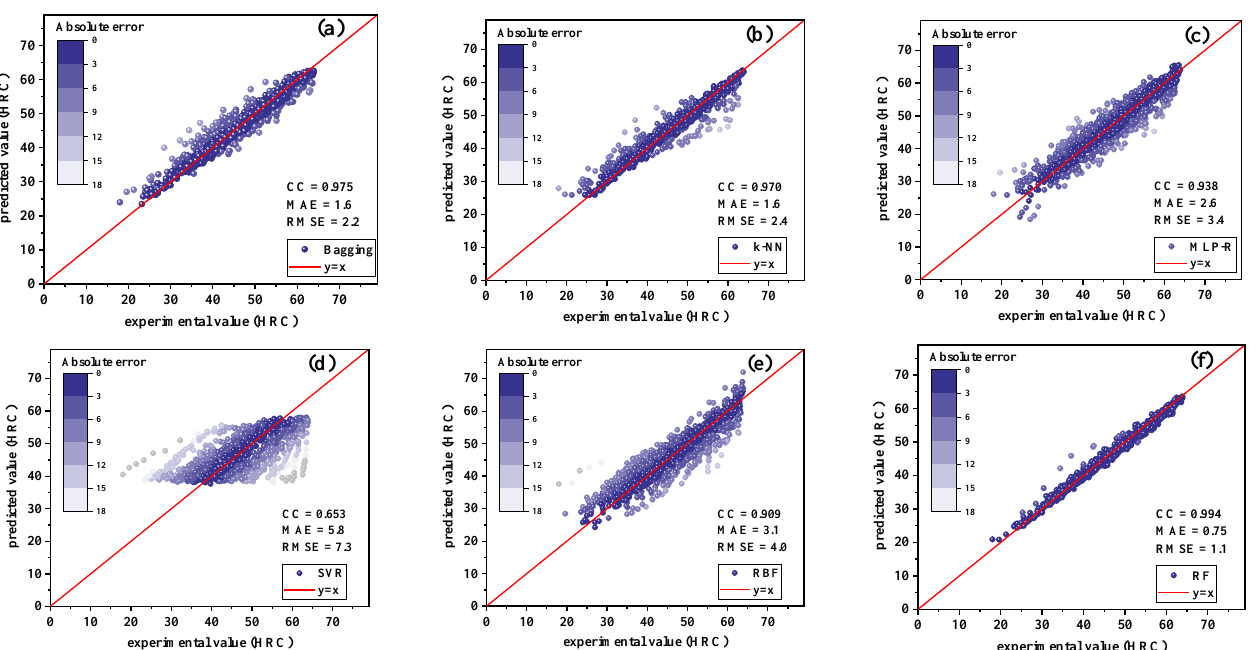
Figure 5. Training results of regression models for high-hardenability steels: ( a ) bagging; ( b ) k-NN; ( c ) MLP-R; ( d ) SVR; ( e ) RBF; ( f ) RF.